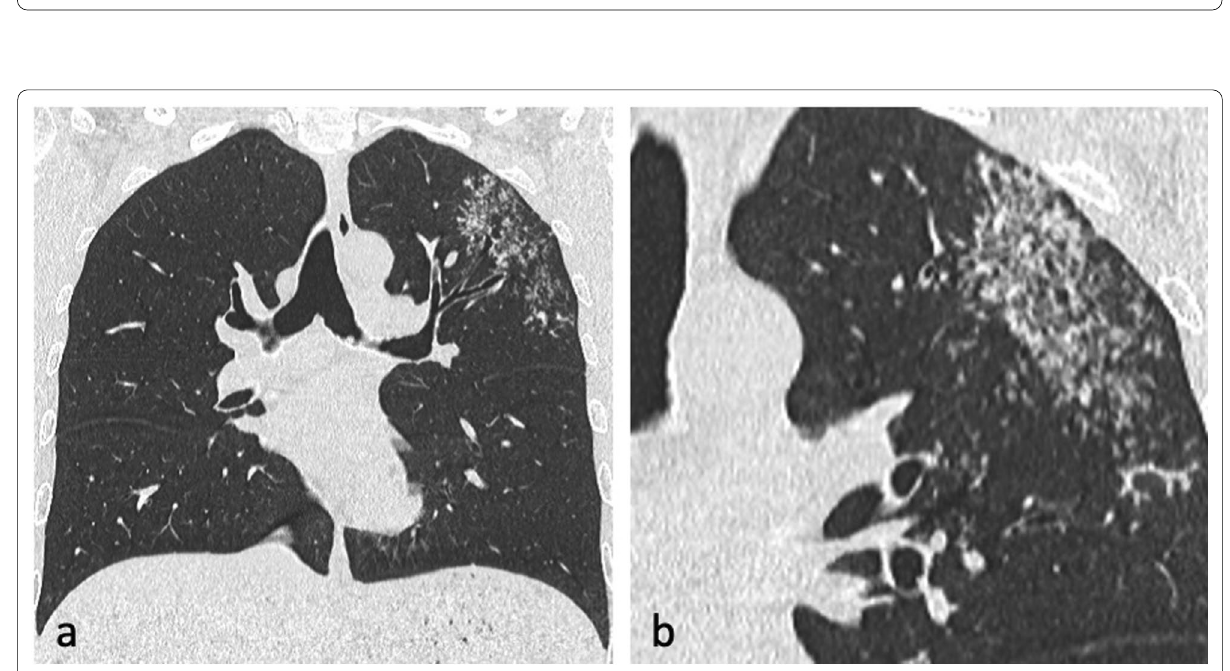
Fig. 7 A 29-year-old male presented with cough and haemoptysis. CT (lung window, coronal planes— a , b ) demonstrates a cluster of tiny nodules within the apicoposterior segment of the left upper lobe with perilymphatic